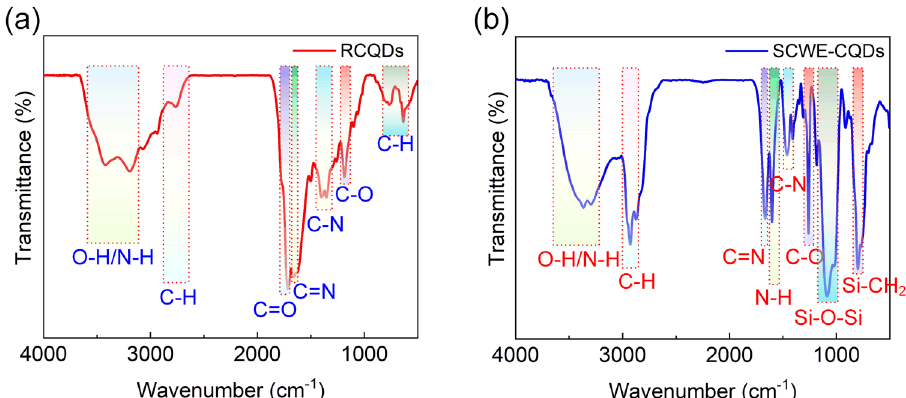
Figure 5: FTIR spectra of ( a ) RCQDs and ( b ) SCWE - CQDs.